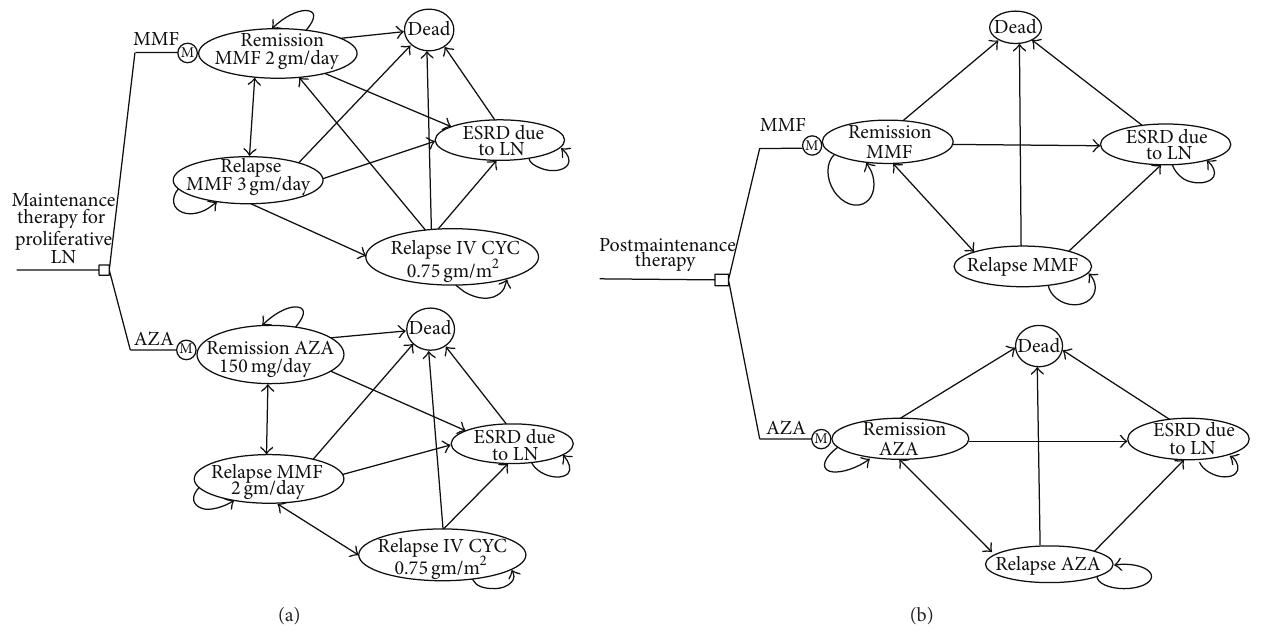
Figure 1: (a) Markov state transition diagram illustrating the health states and transitions for each treatment strategy for the initial 3 years. The lifetime model consists of the initial 3-year period of maintenance therapy followed by a posttreatment phase as shown in (b). (b) Markov state transition diagram illustrating the health states and transitions for each treatment strategy for the posttreatment phase (after 3 years). LN: lupus nephritis; AZA: azathioprine; MMF: mycophenolate mofetil; IV CYC: intravenous cyclophosphamide; ESRD: end stage renal